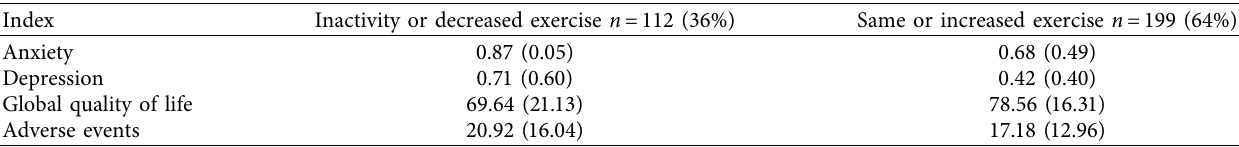
Table 4: Te means and standard deviations (in parenthesis) of psychological well-being and quality of life indices across the change in the level of exercise from baseline to month 12 ( n � 311). Only the indices with a statistically signifcant diference across the changes in levels of exercise are included in the Table.